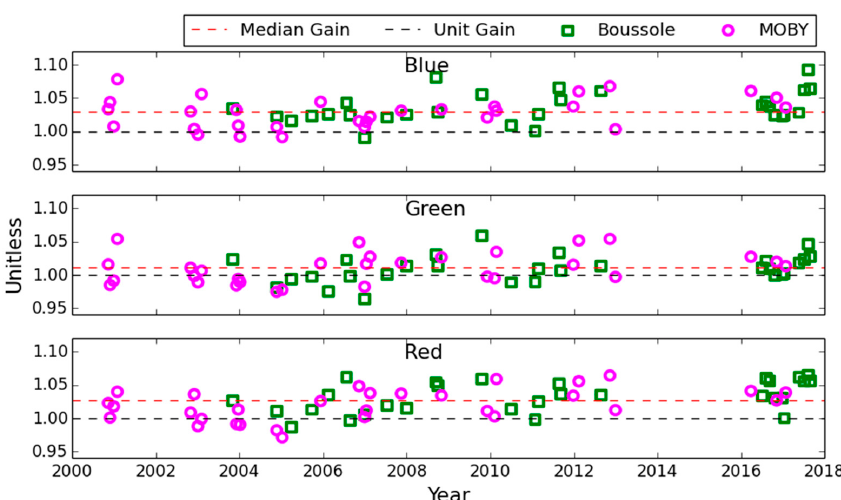
Figure 3. The vicarious gains ( n = 58) for ETM+ visible bands. Each data point corresponds to a computed gain over the MOBY and/or BOUSSOLE site. The temporally median gains and (one) standard deviation applied to ETM+ data are provided in Table 2. Note that the gains are derived after vicariously calibrating NIR and SWIR-I bands in Step I.